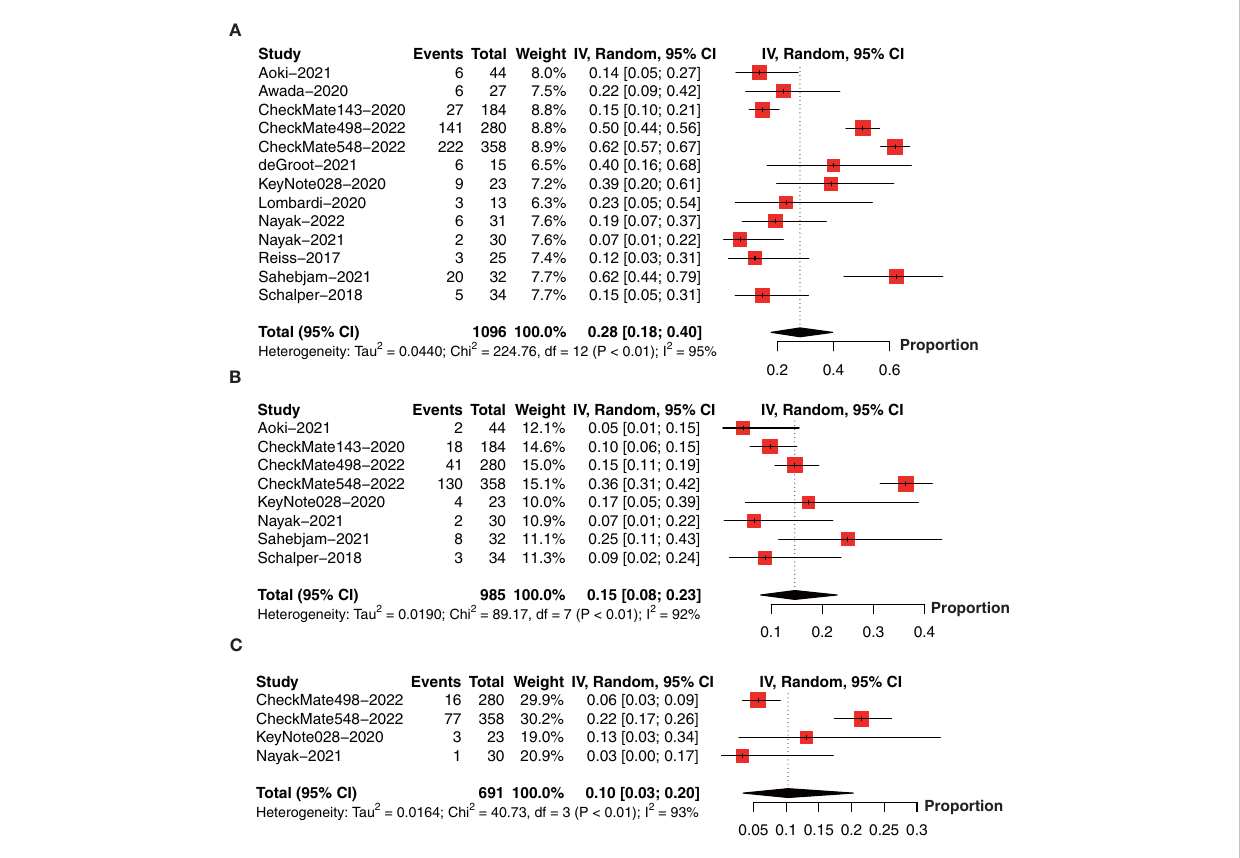
FIGURE 5 Forest plot showing the (A) 6-month, (B) 1-year, and (C) 18-month progression-free survival in glioma patients receiving anti-PD-1/PD-L1